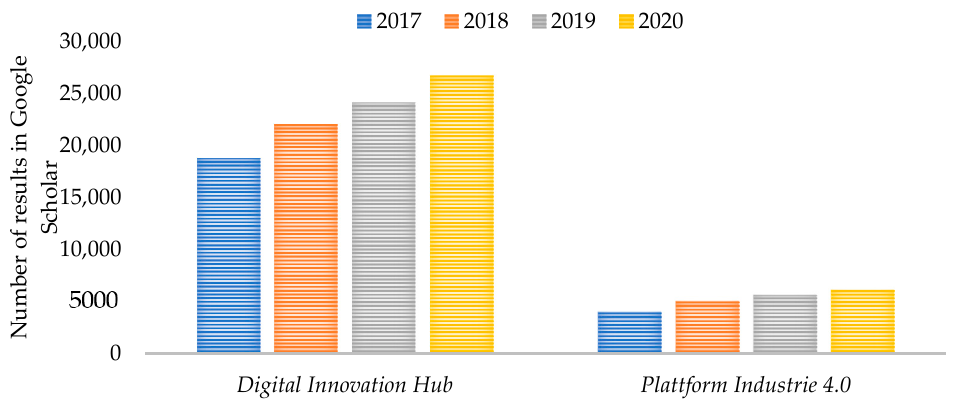
Figure 3. Development during the last four years of the number of results in Google Scholar related to DIH and Plattform Industrie 4.0 .